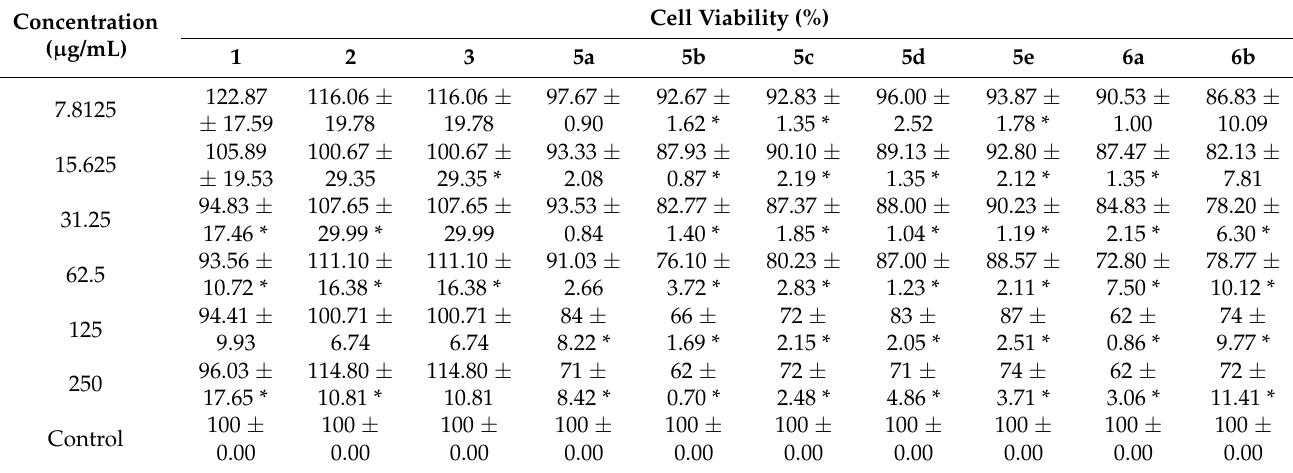
Table 3. Cytotoxicity values of synthesized